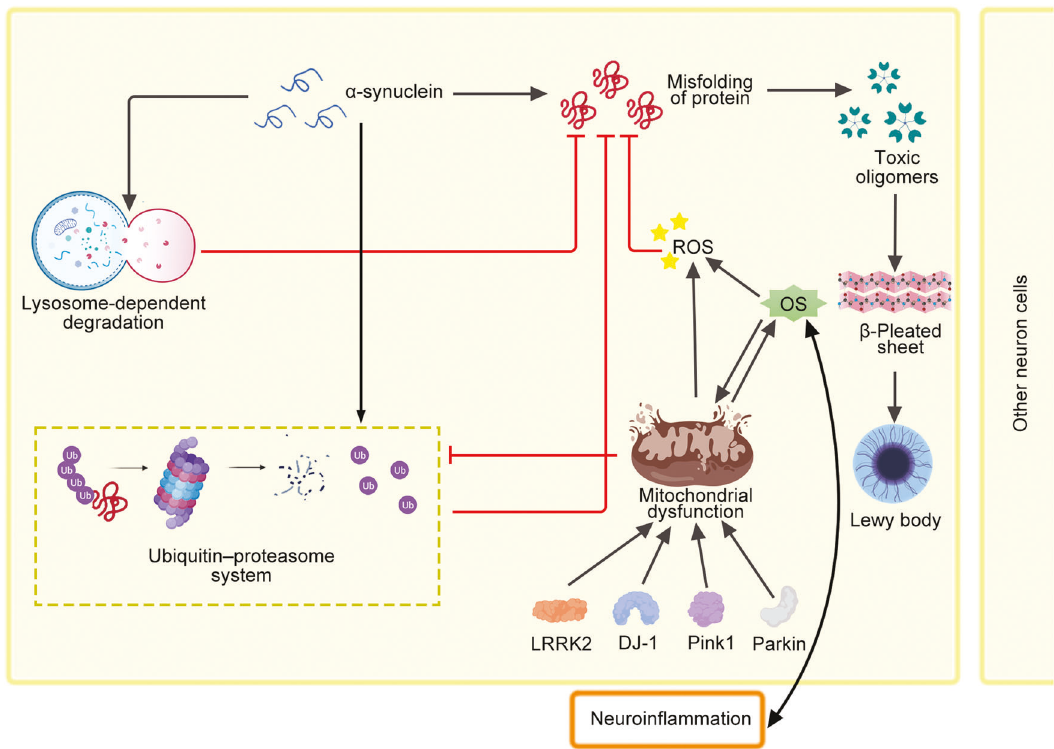
Fig. 2 Intracellular α -synuclein homeostasis is maintained via the ubiquitin – proteasome and lysosomal autophagy systems. Impairment of these degradation systems by OS, mitochondrial dysfunction, or neuroin fl ammation could contribute to α -synuclein accumulation. Furthermore, mutations of genes like LRRK2, DJ-1, Parkin, and Pink1 cause mitochondrial dysfunction and increase cell death. Finally, OS and neuroin fl ammation appear to be